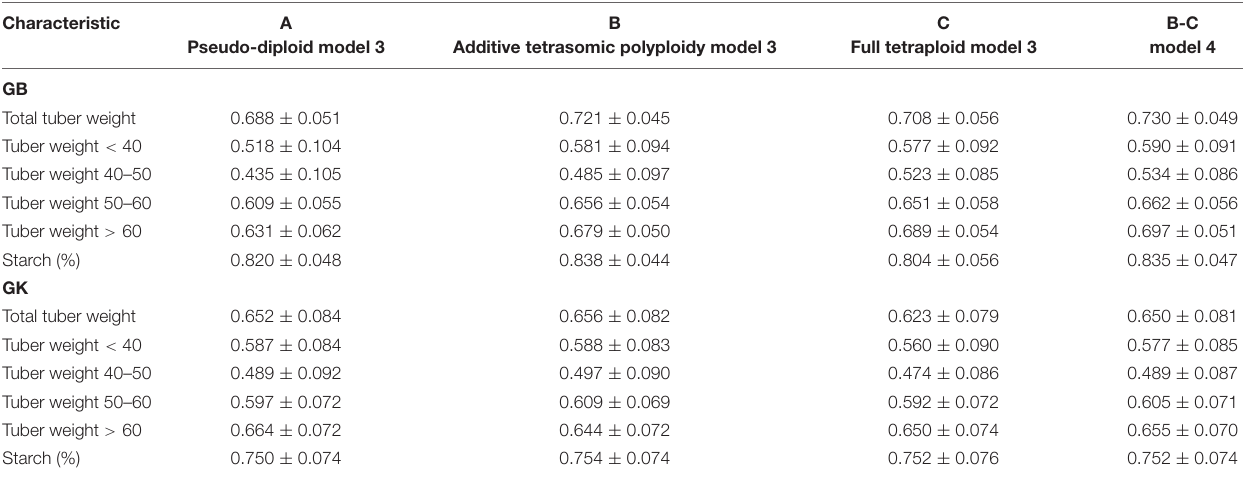
TABLE 6 | Multi-environment, genomic best linear unbiased predictor (GBLUP), and Gaussian-kernel prediction accuracy ( ± standard deviation) for potato tuber characteristics considering pseudo-diploid (A) (model 3), additive tetrasomic polyploid (B) (model 3), full tetraploid (C) (model 3), and B-C (model 4) with fourfold partitions of 10 random samples each in Mosslunda 2020 ( N =